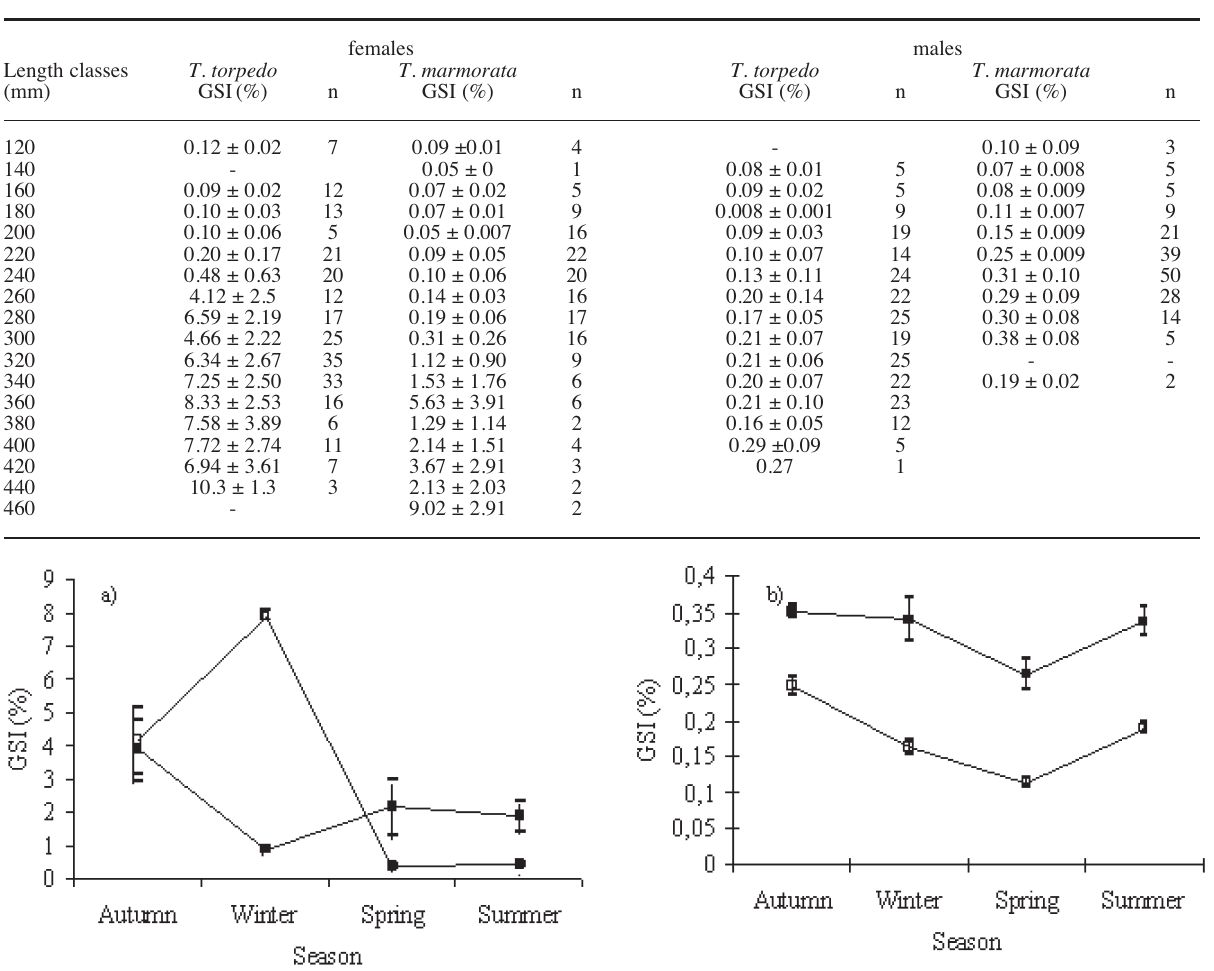
Table 2 . – Variation of mean (± S.D.) gonadosomatic index (GSI) in females and males of T. torpedo and T. marmorata according to size classes. females males Length classes